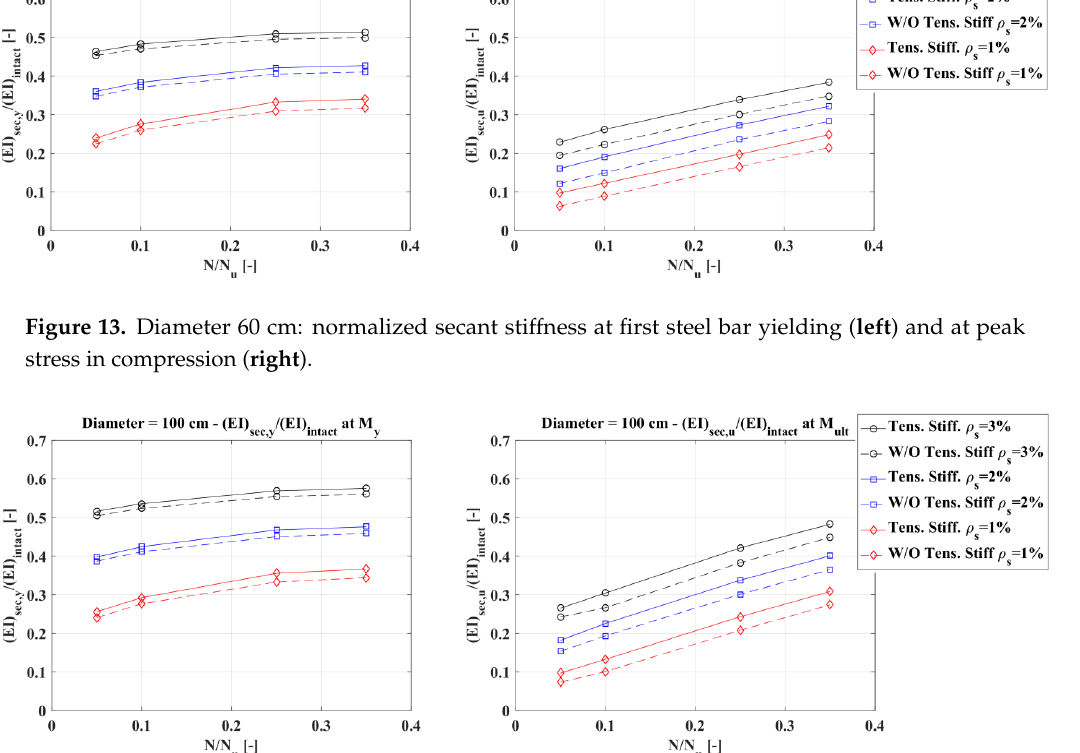
Figure 14. Diameter 100 cm: normalized secant stiffness at first steel bar yielding ( left ) and at peak stress in compression ( right ).